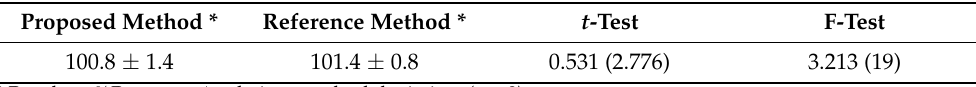
Table 3. Application of the proposed method for the determination of RDS in Remdesivir-Rameda ® .